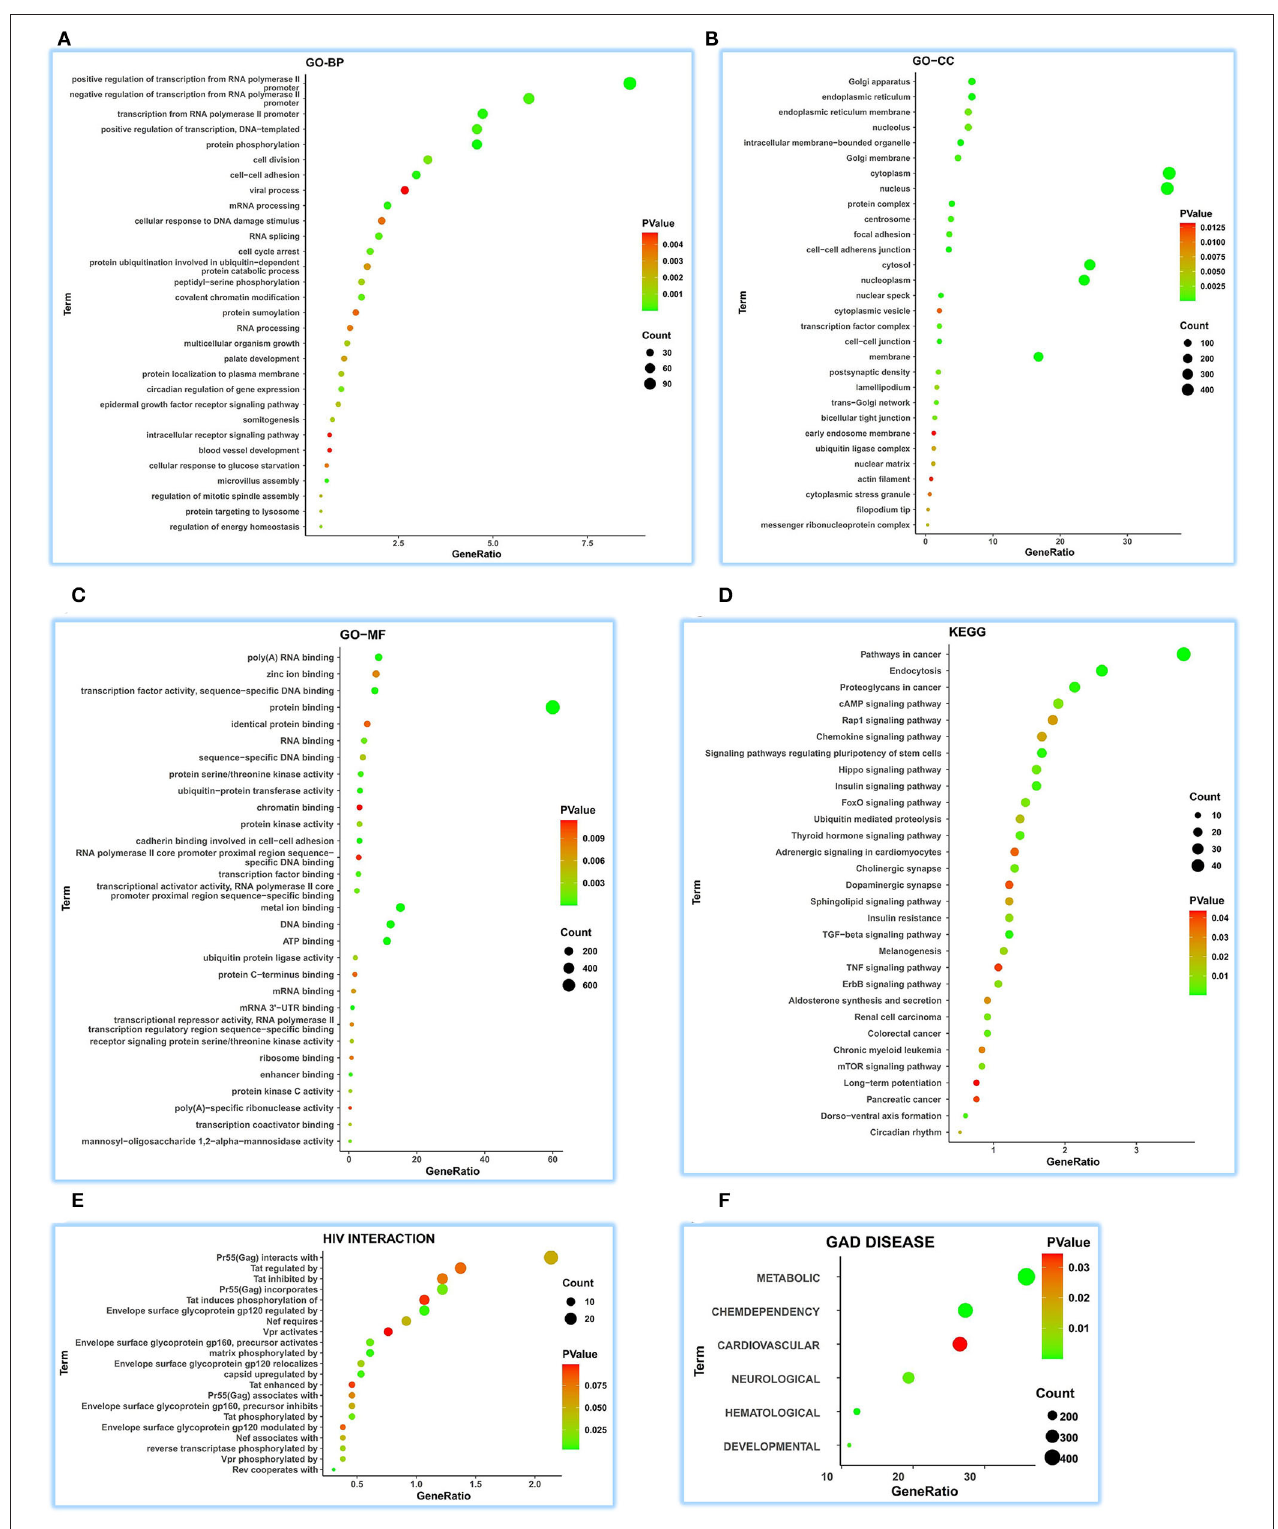
FIGURE 3 | Comprehensive functional notes of ATP5MG by ceRNA analysis. Analyses of GO, KEGG, HIV interaction and GAD DISEASE were conducted using the DAVID tool based on 1326 ceRNA genes of ATP5MG in 32 human tissues. ATP5MG may take on various functions. (A) Functional terms for GO-BP. (B) Functional terms for GO-CC. (C) Functional terms for GO-MF. (D) Functional terms for KEGG pathway. (E) Functional terms for HIV interaction. (F) Functional terms for GAD DISEASE. GO, Gene Ontology; BP, biological process; CC, cellular component; MF, molecular function. KEGG, Kyoto Encyclopedia of Genes and Genomes.